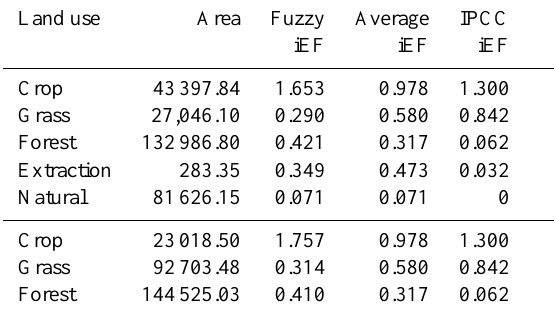
Table 5. Overview of land use areas on organic soils in Europe and corresponding implied emission factors (iEF) for the Fuzzy logic model (Fuzzy), the average emission factors of flux data from this study (Average) and IPCC emission factor approach (IPCC). The land areas are shown in km 2 for CLC 2006 (top) and HILDA 2010 (bottom), respectively. The emission factors are derived from the mean N 2 O flux budget divided by particular land use class area and are displayed in gN 2 O-Nm − 2 a − 1